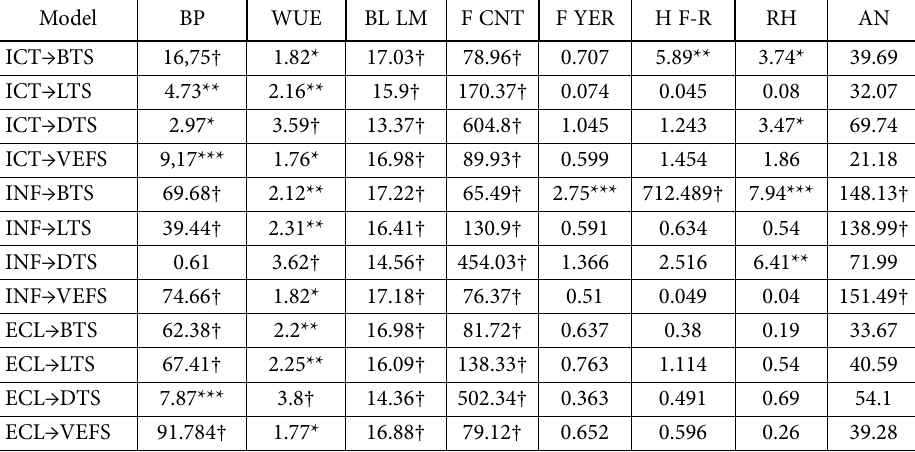
Table 5. Tests of assumptions of the panel regression model